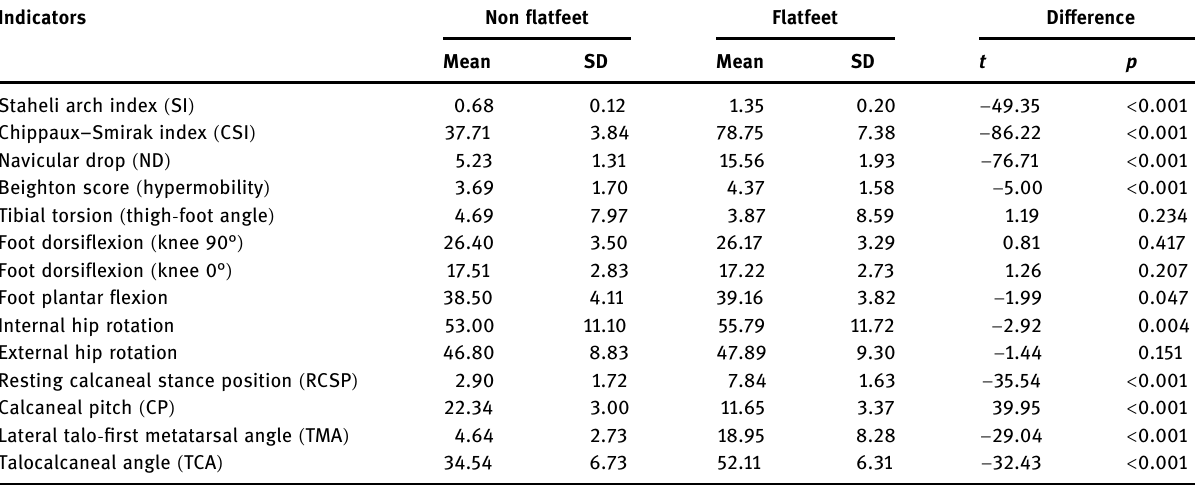
Table 3: Comparison of study indicators in children with fl at and non - fl atfeet Indicators